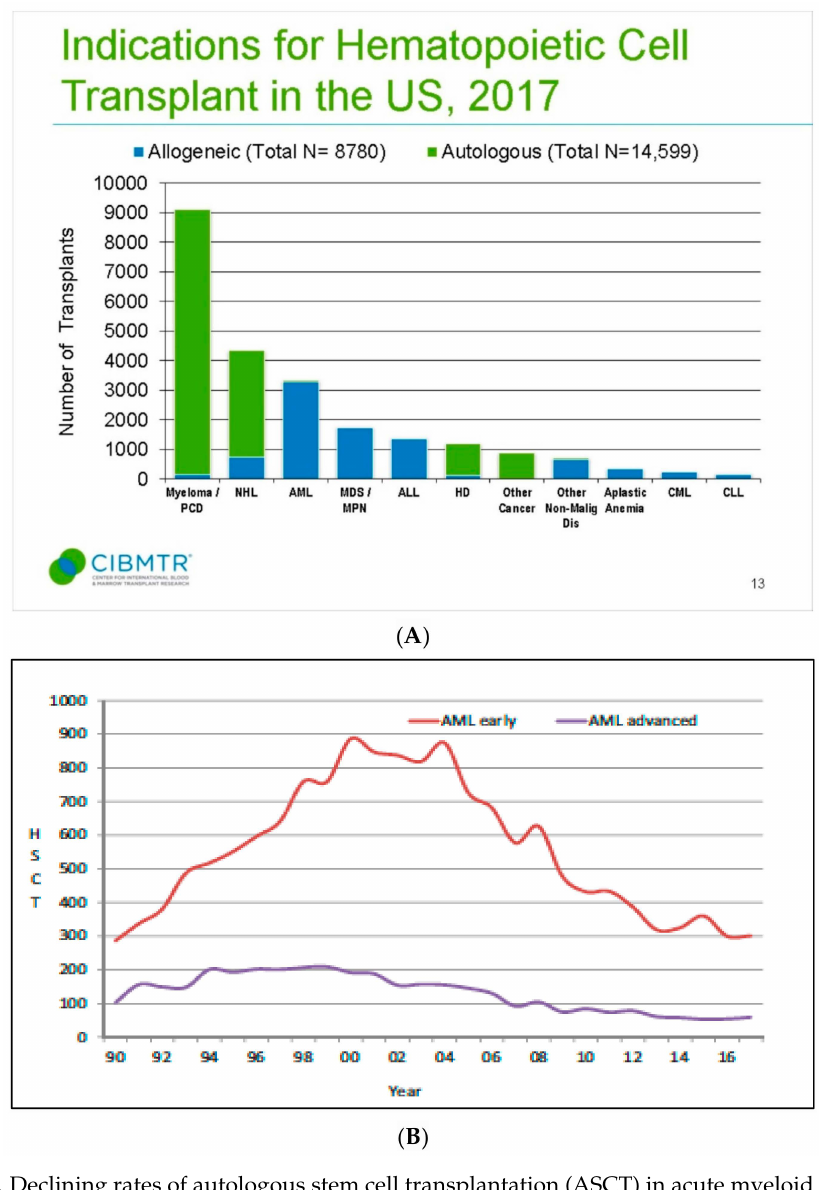
Figure 1. Declining rates of autologous stem cell transplantation (ASCT) in acute myeloid leukemia (AML) in the USA (panel ( A ), accessed at www.CIBMTR.org) and Europe (panel ( B )